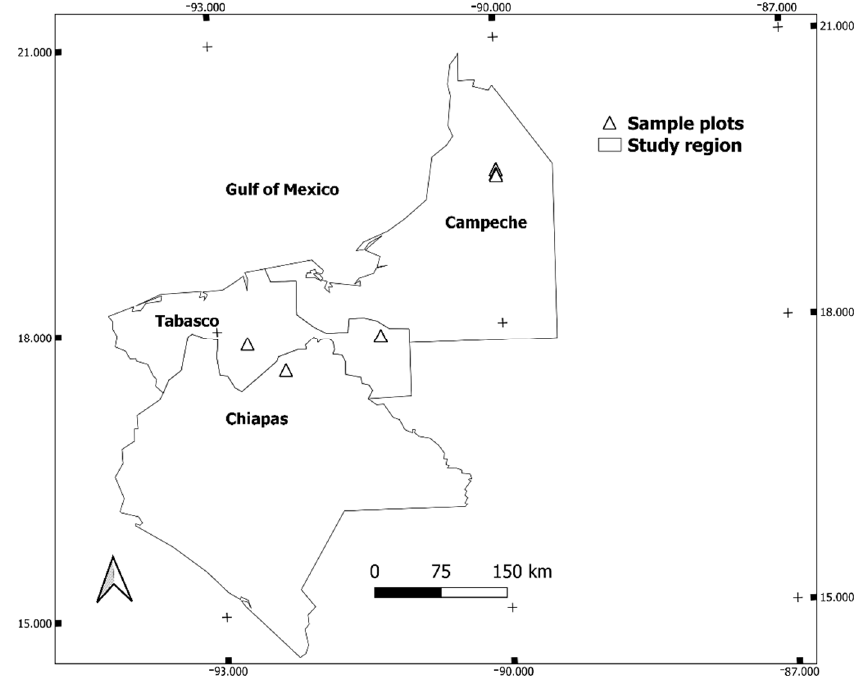
Figure 1. Map of locations of sampling plots in three states of the Mexican republic. Table 1. Descriptive statistics of trees from the sample for tapering.